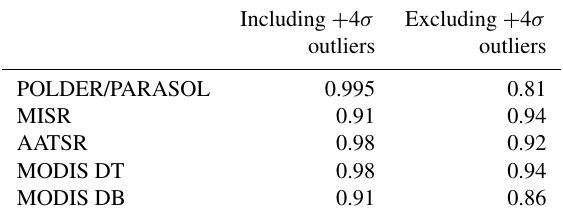
Table 5. Correlation of annual mean AODs with Fort McMurray AERONET AODs during the respective overlap periods of the var- ious satellite AOD products. In the rightmost column, the contribu- tion of large forest fires has been removed from AERONET data and satellite data sets using + 4 standard deviations ( σ ) as a